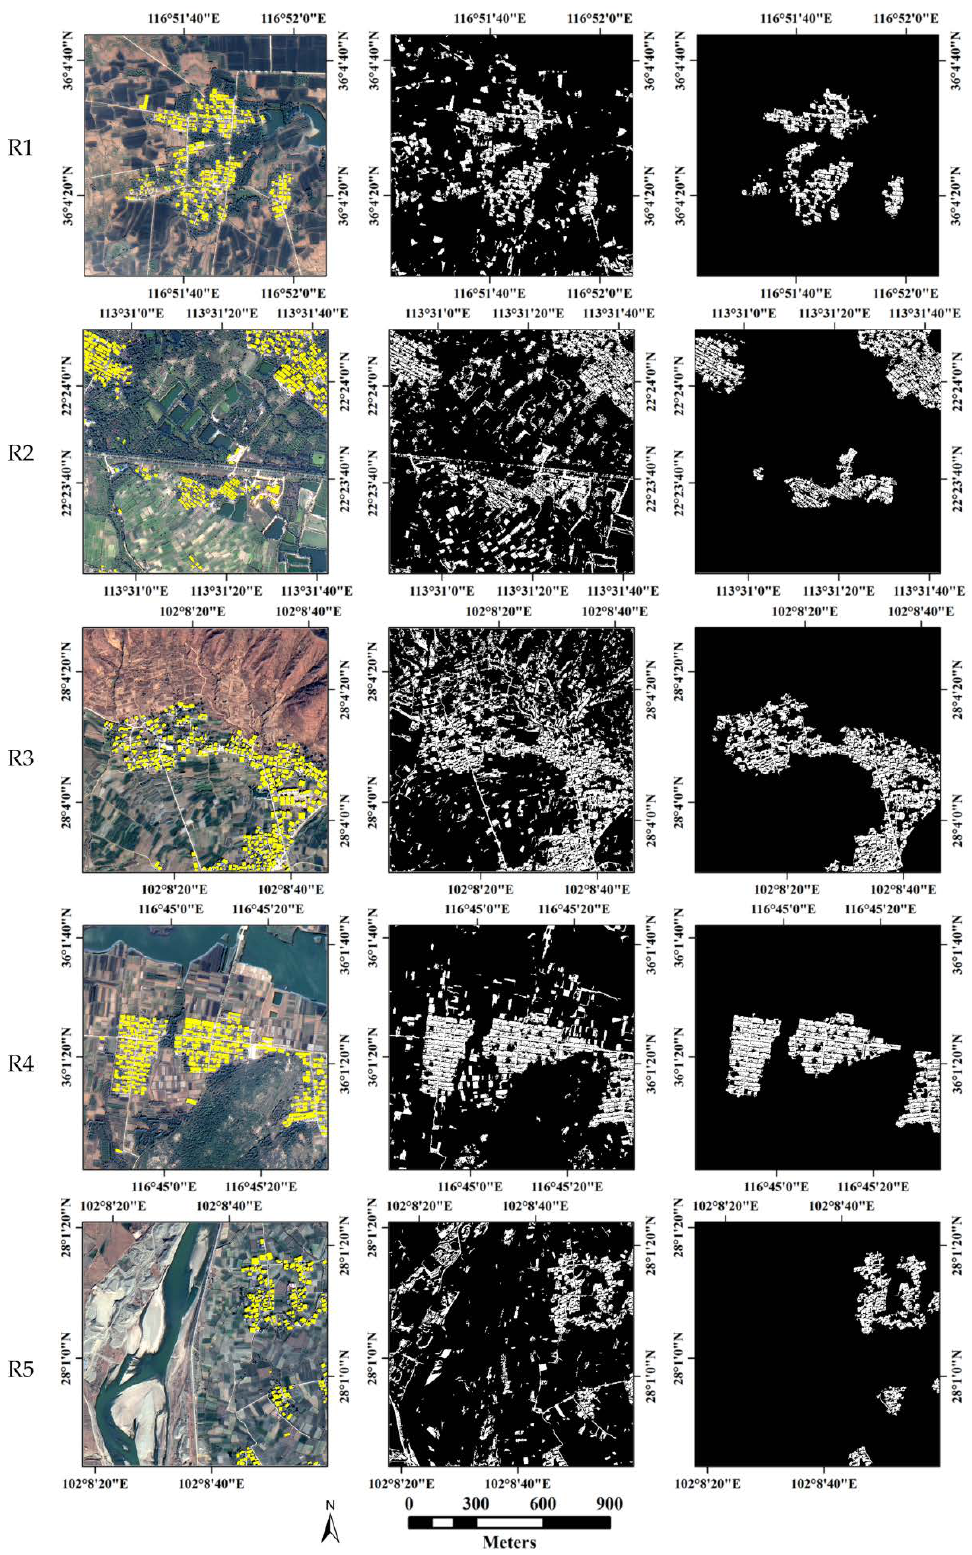
Figure 7. Building detection results. ( first column ) Reference maps of building distribution (marked with yellow-colored areas); ( second column ) Building maps extracted with the original morphological building index (MBI) algorithm; ( third column ) Building maps extracted with our method.